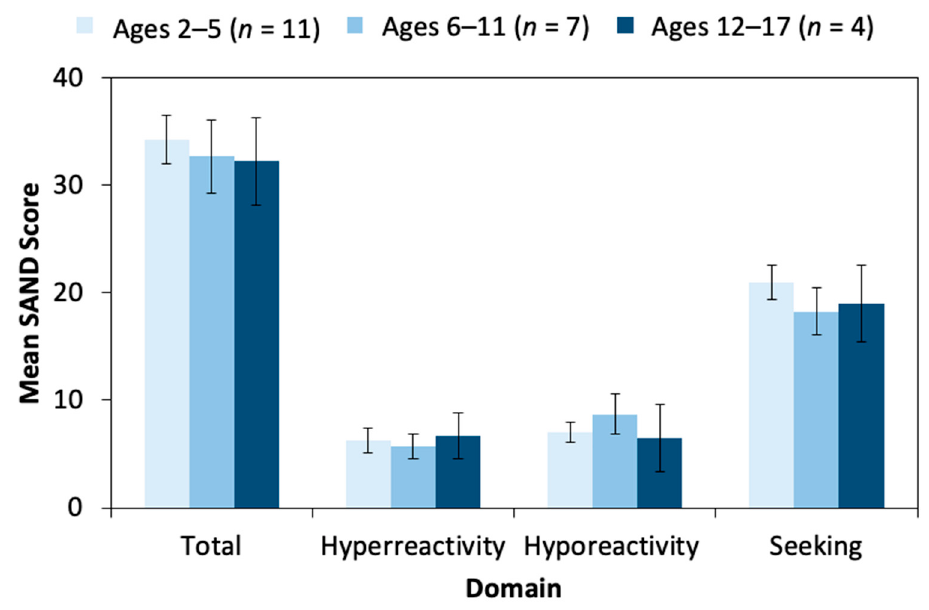
Figure 3. Sensory symptoms within three age cohorts reflecting early childhood, middle child- hood, and adolescence. Results display stability in SAND scores across age groups. and adolescence. Results display stability in SAND scores across age